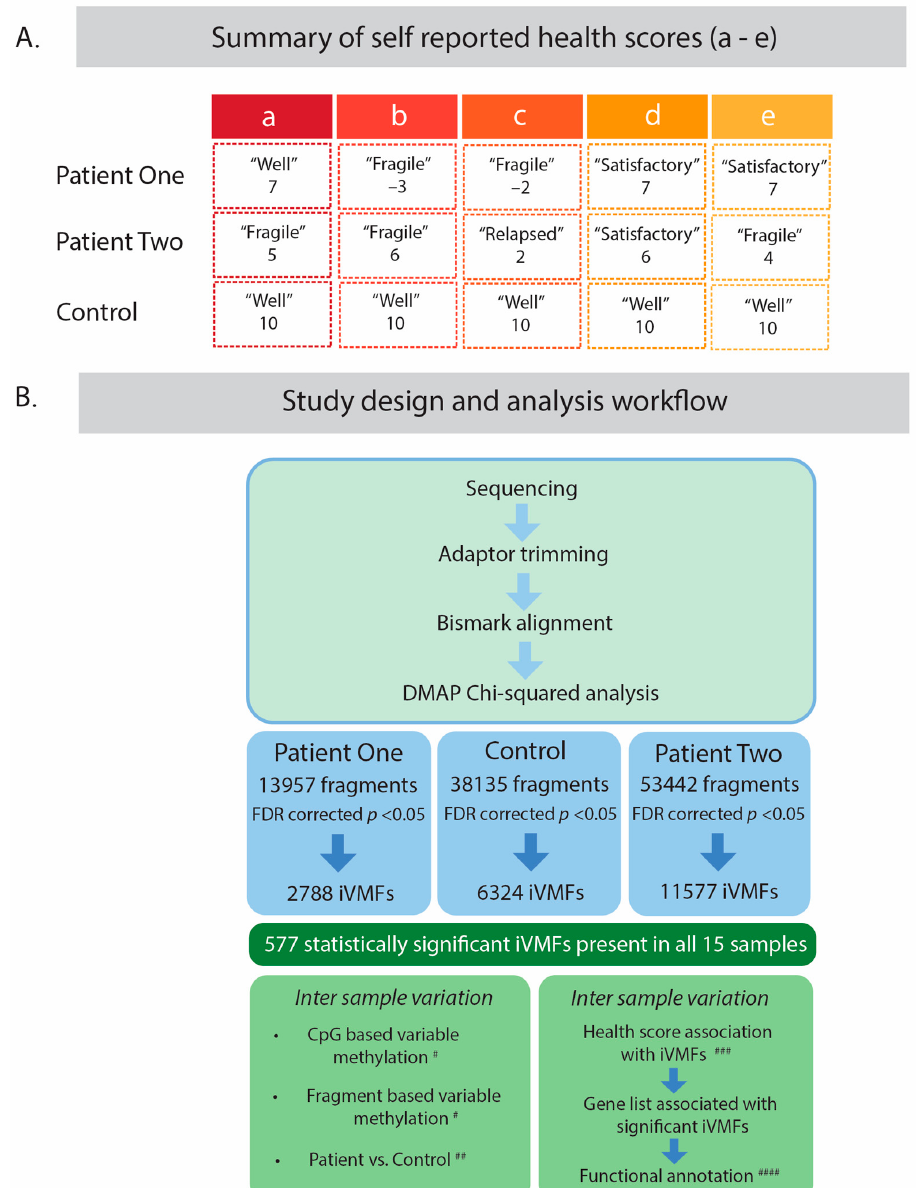
Figure 1. Study design. ( A ) Summary of self-reported health status of study subjects through a relapse and relative recovery cycle. The timeline of the health status of two patients over an 11 month period that spanned a relapse in each patient is shown along with the matched control. Self-reported information from the patients that they supplied on the day of blood donation indicated their health status (between –3 and 10). ( B ) The study design for longitudinal analysis. Following RRBS, and adaptor trimming and alignment of the data to human reference genome hg19 using Bismark, each sample was analysed. Initial estimates of variation utilised genome wide CpG methylation information, before the samples were analysed utilising the DMAP platform where a Chi squared analysis was used to identify methylation variation. The fragment methylation was also used to estimate variation but at key genomic locations. Comparisons were made between the patients and control. Continued analysis utilised the 577 statistically significant variable fragments identified across all 15 samples (FDR corrected p < 0.05) where correlation was calculated with health scores and ‘relapse’ and ‘recovery’ events to identify intra-individual variably methylated fragments (iVMFs). Genes associated with the individuals iVMFs were determined and functional categories